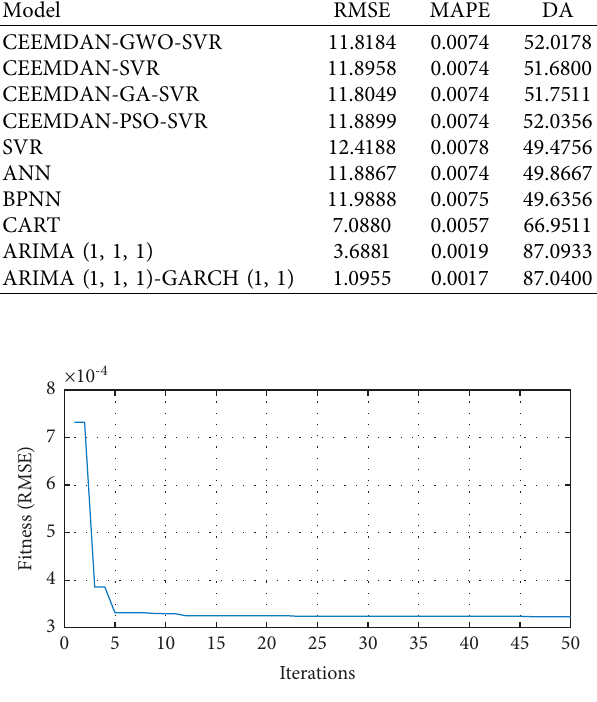
Figure 7: Te convergence plots of GWO.